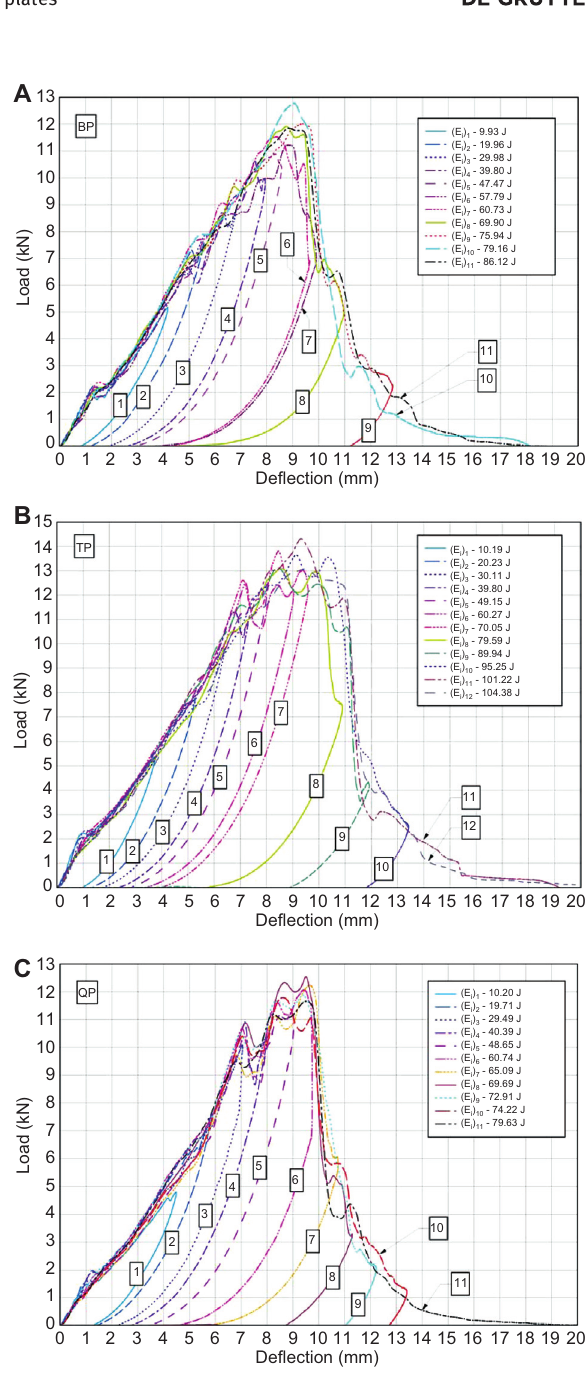
Figure 3 Typical load-deflection (F-d) curves for the (A) BP, (B) TP, and (C) QP